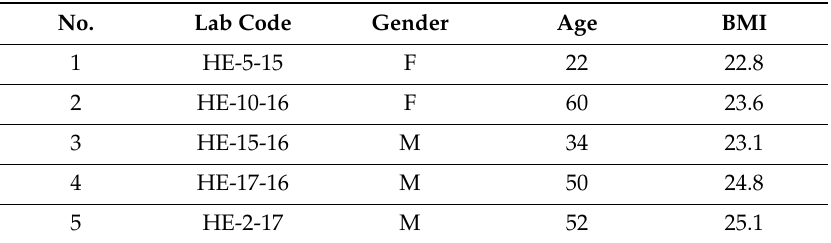
Table 1. Characteristics of human donors of pancreatic